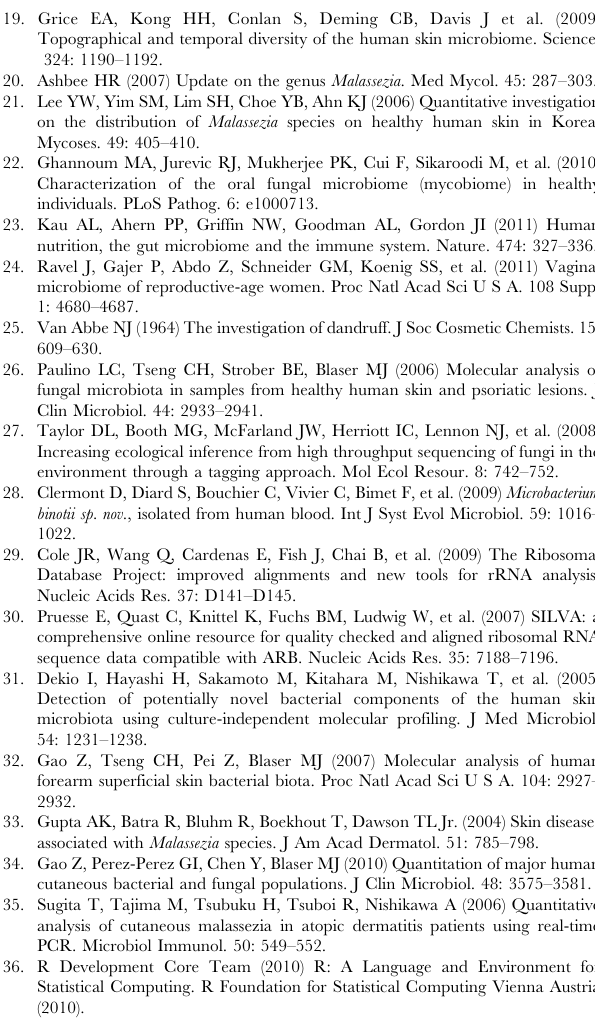
rial and fungal species found in this study. Accession numbers of highest homology matches used for the confirmation of identity are